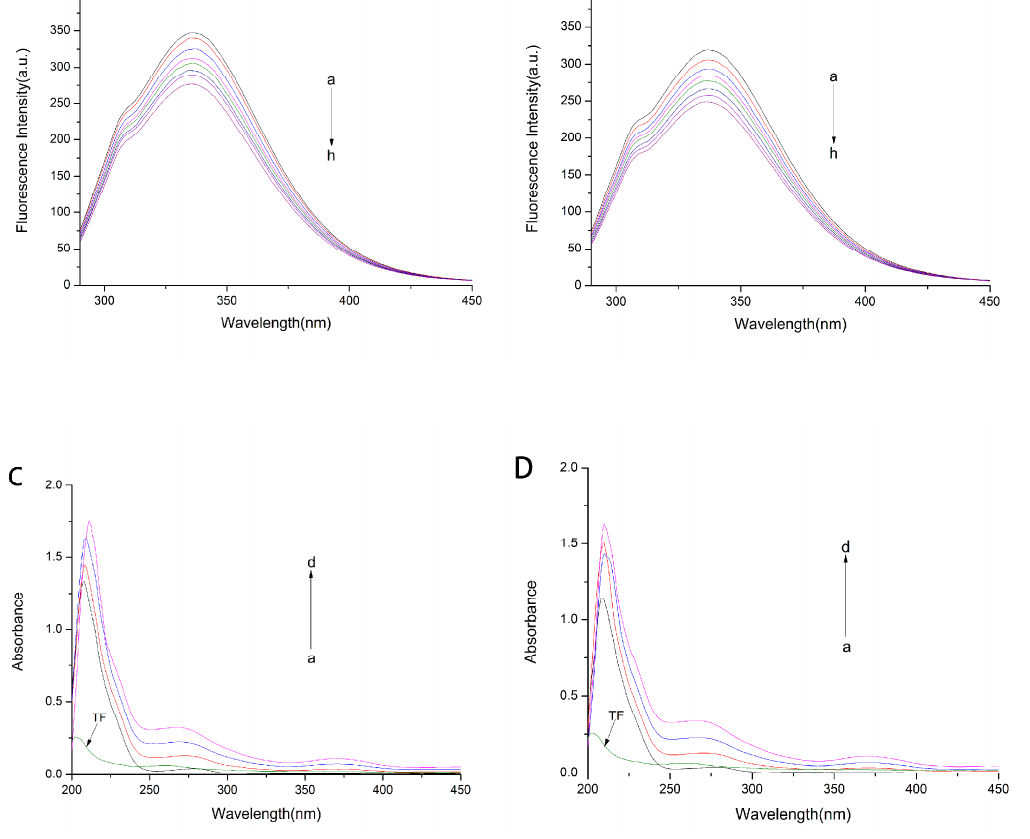
Figure 2. Effect of TF on fluorescence spectrum of HSA ( A ) and glycated human serum albumin (GHSA) ( B ). The fluorescence spectrum of the system is excited at 280 nm and the emission wavelength is in the wavelength range 290–450 nm. a–h: C HSA / C TF = C GHSA / C TF = 1:0, 1:1, 1:2, 1:3, 1:4, 1:5, 1:6 and 1:7. UV absorption spectra of HSA ( C ) and GHSA ( D ) without and with TF. a–d: C HSA / C TF = C GHSA / C TF = 1:0, 1:2, 1:4 and 1:6. The green line is the UV absorption spectrum of TF.